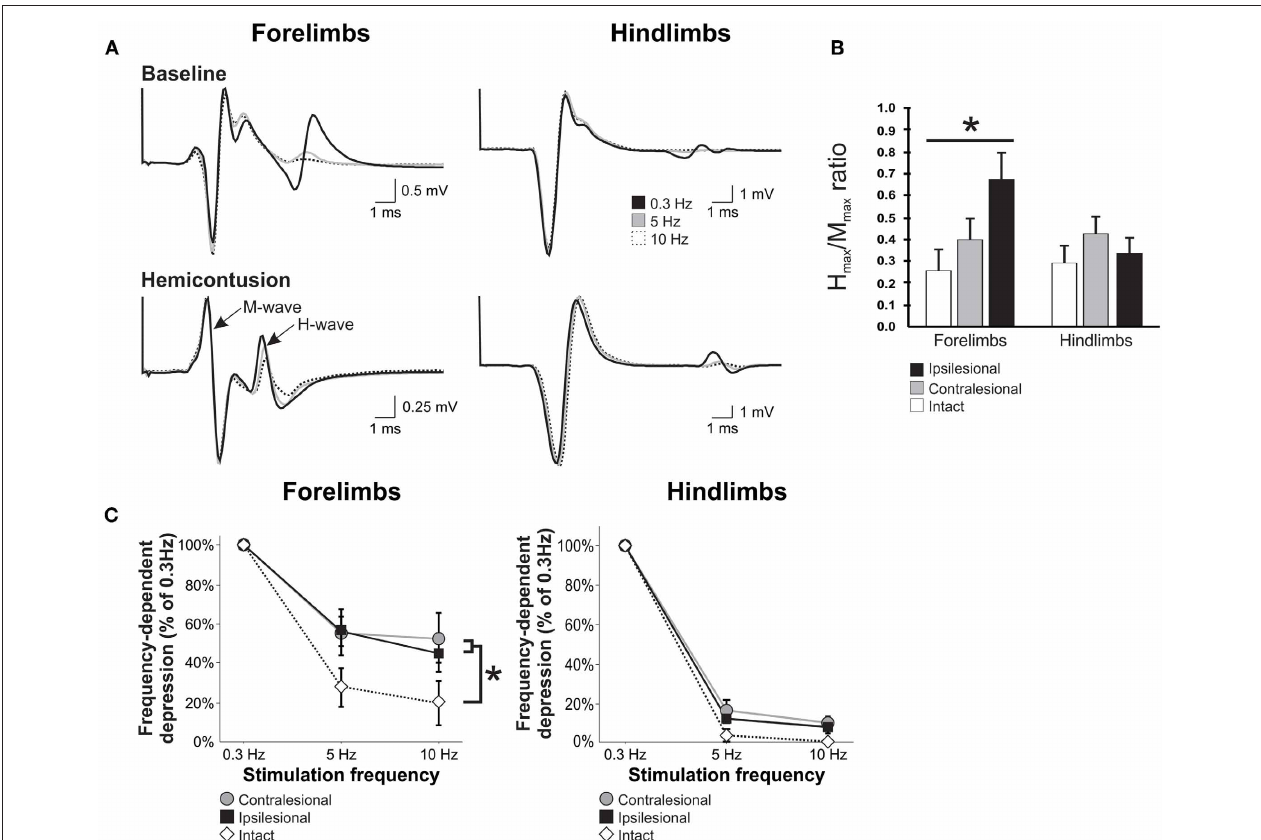
FIGURE 5 | Unilateral cervical SCI affects H-reflex modulation bilaterally in the forelimbs, but not in the hindlimbs. H-reflex traces were evoked by the stimulation of the tibial or ulnar nerve and recorded from the interosseus muscle of ipsilesional and contralesional hindlimb and forelimb. (A) Representative average of H-reflex recordings following a train of stimulation at 0.3Hz (black), 5Hz (gray), and 10Hz (white) in normal and SCI animals. There was a decrease in the average amplitude of the H-reflex with increasing stimulus frequency in the hindlimbs and forelimbs